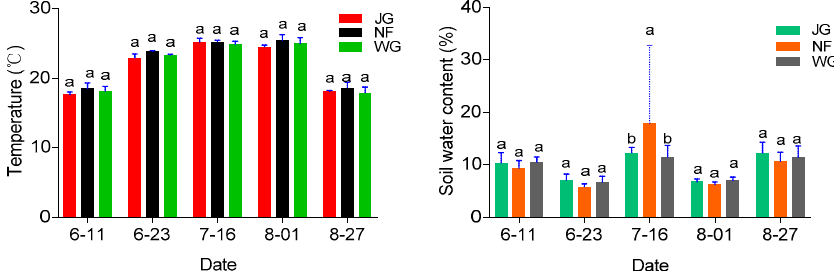
Figure 5. Soil temperature (soil layer of 0–20 cm) and soil water content (soil layer of 0–100 cm) of maize at different growth stages. Note: JG represents straw mulching; NF represents organic fertilizer mulching; WG represents no mulching; data represents mean ± standard error ( n = 17). Bars labeled with different letters (lowercase) differed significantly among the treatments ( p <0.05).